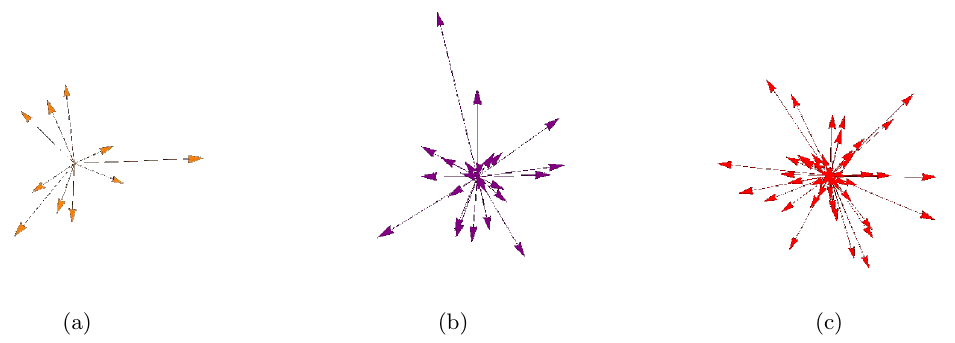
Figure 7 . Examples of events generated according to uniform N -body phase space for (a) N = 10, (b) N = 25, and (c) N = 50. The magnitude of each vector is proportional to the energy of the corresponding